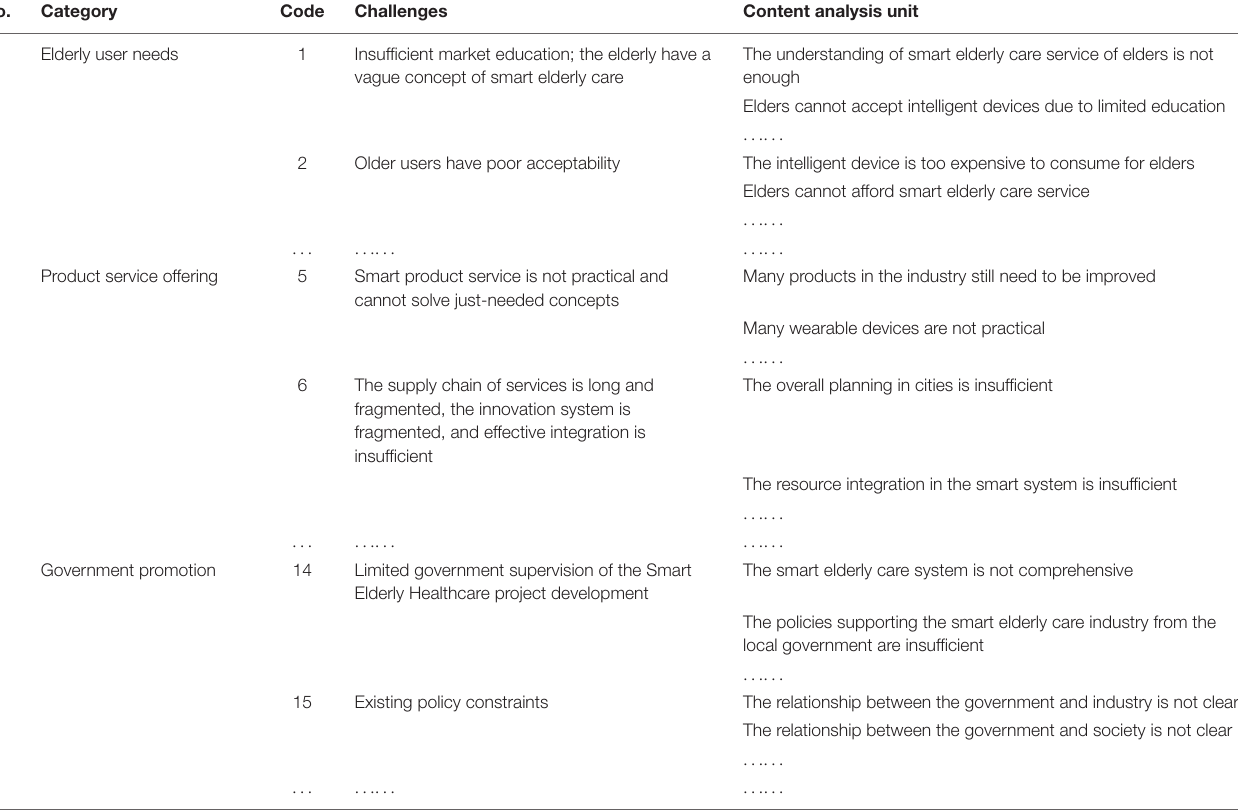
TABLE 3 | The content analysis coding table of challenges in the industry. No.